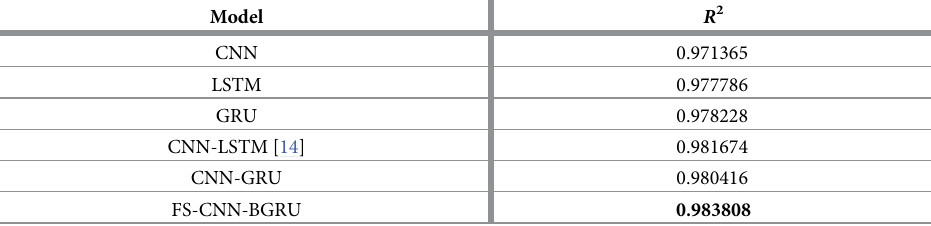
Table 10. R 2 of different